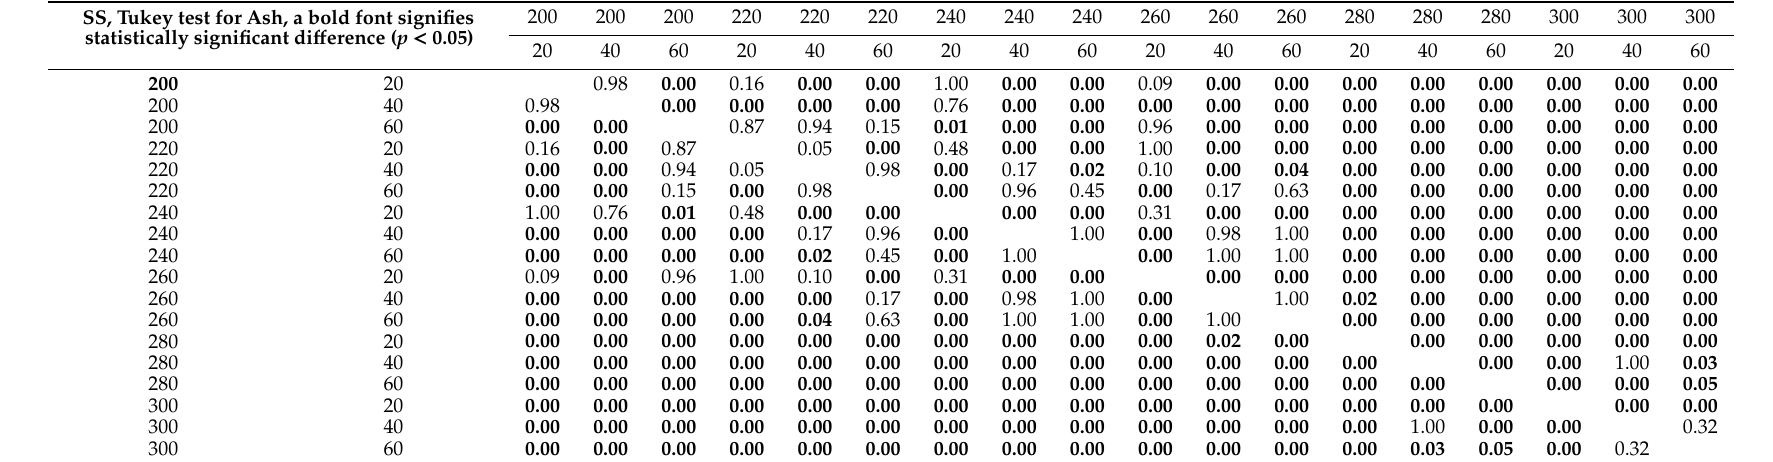
Table A10. Analysis of variance for ash content of sewage sludge.